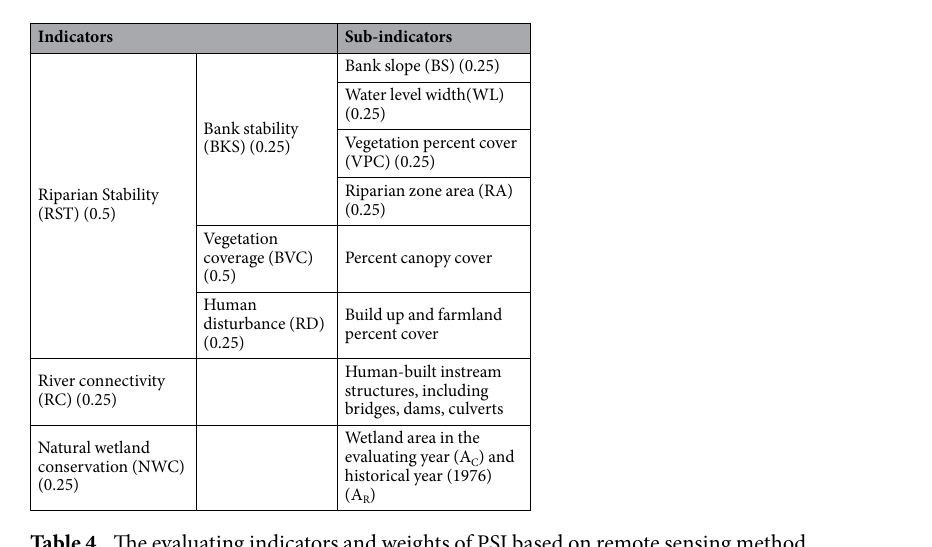
Table 4. The evaluating indicators and weights of PSI based on remote sensing method.